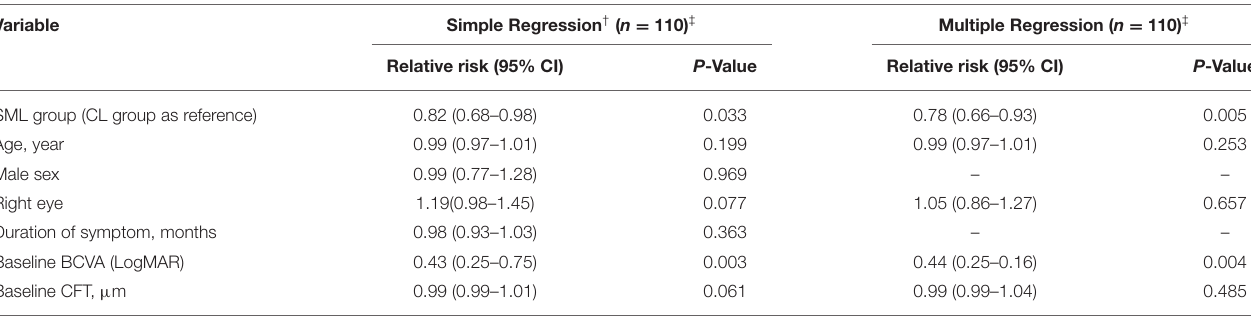
TABLE 2 | Intention-to-treat analysis of potential determinants of SRF at 3-months follow-up.